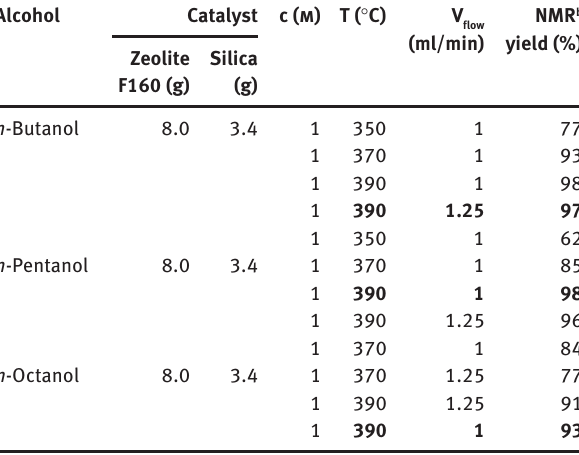
a Reaction conditions: 13 ml void volume, 90 bar pressure. Selec- tivities were found > 97%, based on gas chromatography-mass